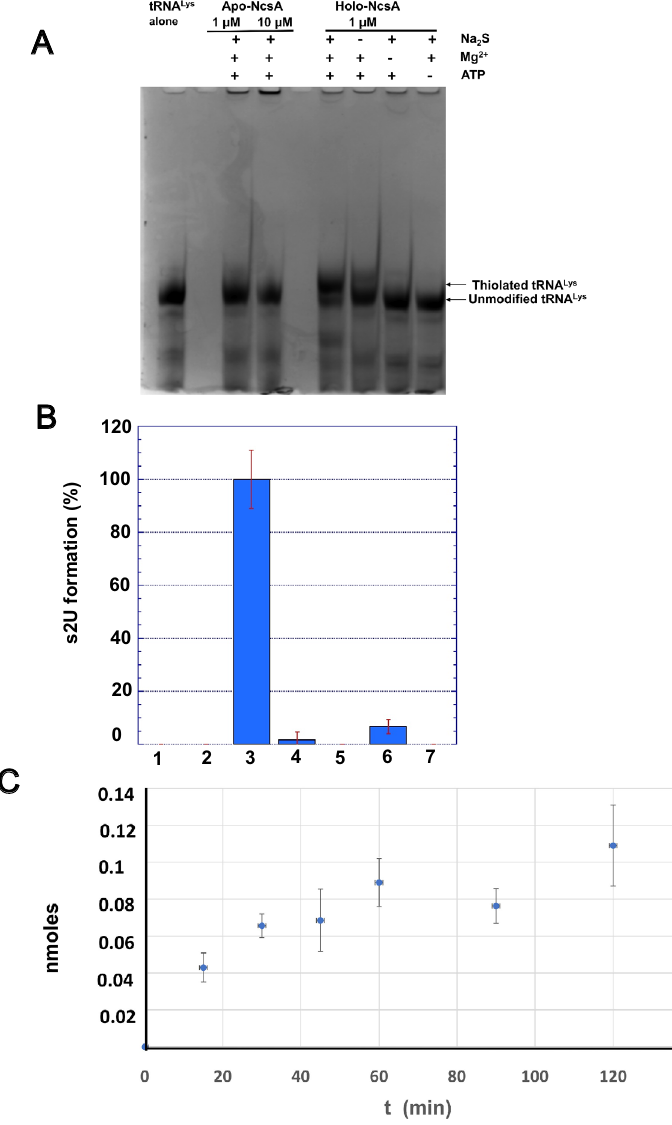
Figure 3. In vitro tRNA thiolation activity assays. ( A ) In vitro tRNA thiolation activity tests under anaerobic conditions monitored on an APM-retardation gel. 15 µM in vitro transcribed tRNA Lys UUU was incubated for 1 h at 37 °C in 25 mM HEPES pH 7.5, 200 mM NaCl, with apo-MmNcsA or holo-MmNcsA, in the presence or absence of 1 mM Na 2 S, 5 mM MgCl 2 , 1 mM ATP. ( B ) Conditions for s 2 U formation monitored by HPLC- coupled MS/MS after tRNA digestion. The data shown are mean values based on 3 different experiments. ( 1 ) tRNA Lys UUU alone, 10 µM apo-MmNcsA ( 2 ), or 1 µM holo-MmNcsA ( 3 ) incubated for 1 h with 20 µM tRNA Lys UUU , 2.5 mM MgCl 2 , 0.25 mM Na 2 S and 0.25 mM ATP. Control reactions: no Na 2 S ( 4 ), no MgCl 2 ( 5 ), no ATP ( 6 ), U34A-tRNALys UUU ( 7 ). 100% activity corresponds to 0.1 nmol s 2 U formed in 60 min. ( C ) Quantification of s 2 U formation catalyzed by 1 µM holo-MmNcsA incubated with 20 µM tRNA Lys UUU in the presence of 0.25 mM ATP, 0.25 mM sodium sulfide and 2.5 mM MgCl 2 monitored by HPLC-coupled MS/MS after tRNA